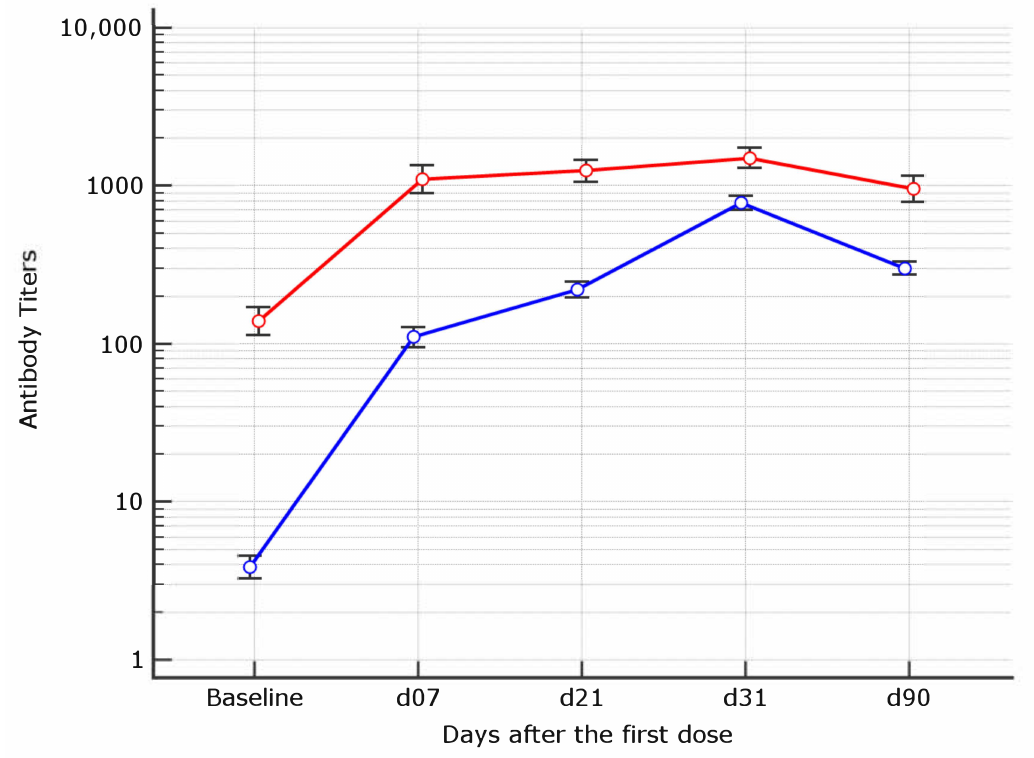
Figure 2. Geometric mean antibody titers kinetics in healthcare workers by prior COVID-19 experience Figure 90 days after the first BNT162b mRNA dose (red line = COVID-19 experienced, blue line = COVID-19 naive). The highest threshold of the assay is 35.200